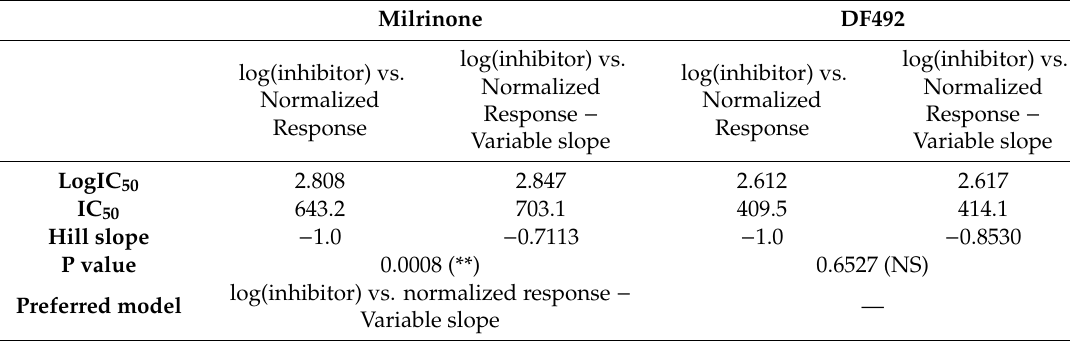
Table 5. Statistical comparison between two models considered: “log inhibitors versus normalized response” and “log inhibitors versus normalized response − variable slope” for each inhibitor. The table lists the LogIC 50 and IC 50 obtained from the comparison, the Hill slope considered and the preferred model resulted. ** means p -value < 0.01, NS means Not significant at t test.